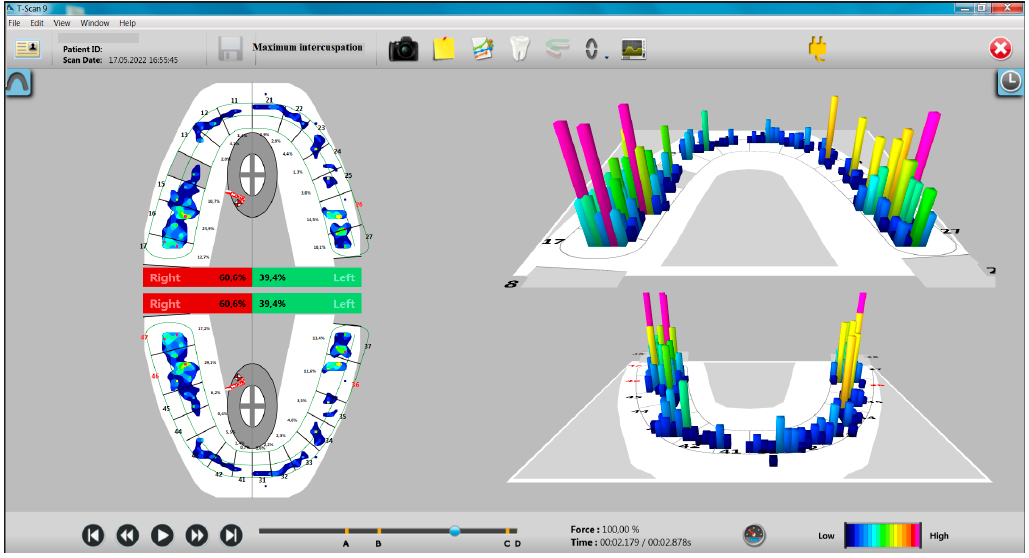
Figure 1. Aspects of T-Scan recording in MI for a participant with bruxism.